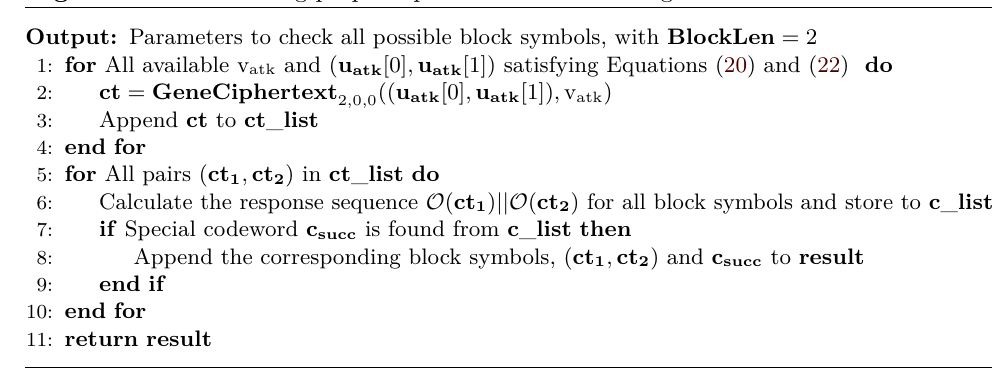
Algorithm 5 Generating proper ciphertexts for “Checking” when BlockLen =